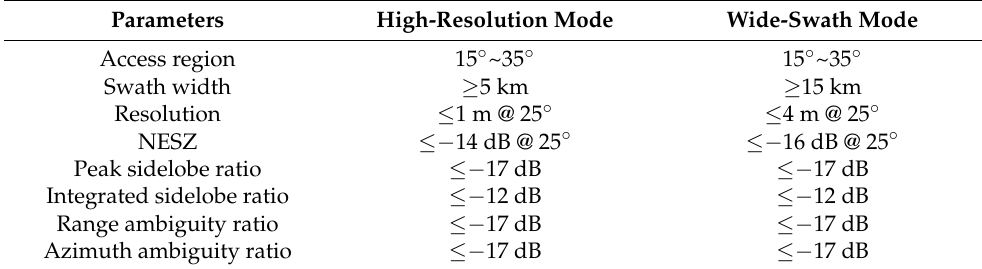
Table 2. S-STEP SAR payload key performance